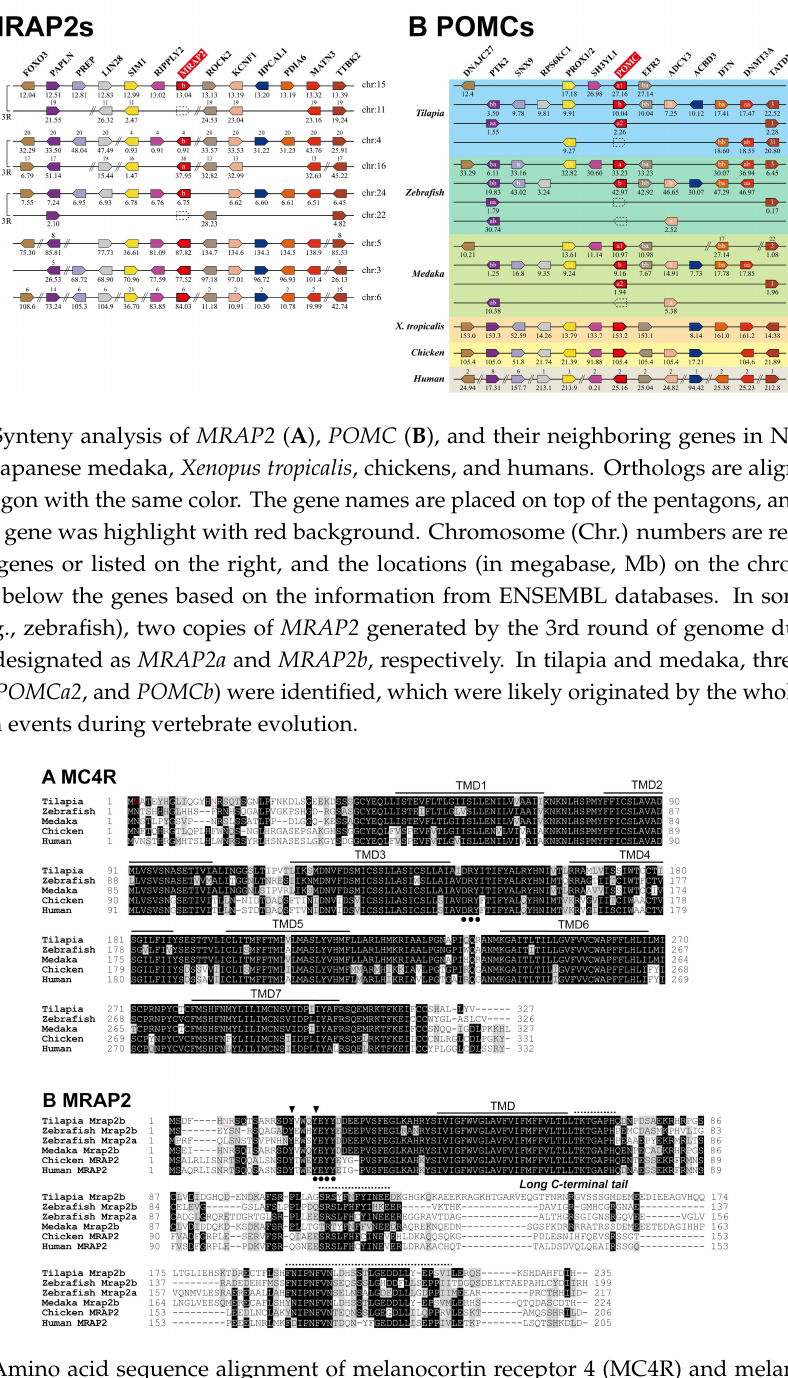
Figure 2. Amino acid sequence alignment of melanocortin receptor 4 (MC4R) and melanocortin-2 receptor accessory protein 2 (MRAP2). ( A ) Amino acid alignment of tilapia MC4R (MT500790) with that of zebrafish (NP_775385), medaka (XP_004081243), chickens (NP_001026685), and humans (NP_005903). Horizontal lines mark the seven putative transmembrane domains (TMD1–7). Two N -glycosylation sites are underlined and highlighted in red. The DRY motif is highlighted with dark dots. ( B ) Alignment of tilapia MRAP2b (MT500791) with that of zebrafish (mrap2a: XP_001342923, mrap2b: XP_005168578), medaka (XP_004083625), chickens (NP_001307836) and humans (NP_612418). Horizontal line marks the transmembrane domains (TMD). An N -glycosylation site is underlined and highlighted in red. Dots / arrowheads indicate the residues conserved in MRAP2s across vertebrates. The three conserved regions in the long C-termini of vertebrate MRAP2s are indicated by dotted